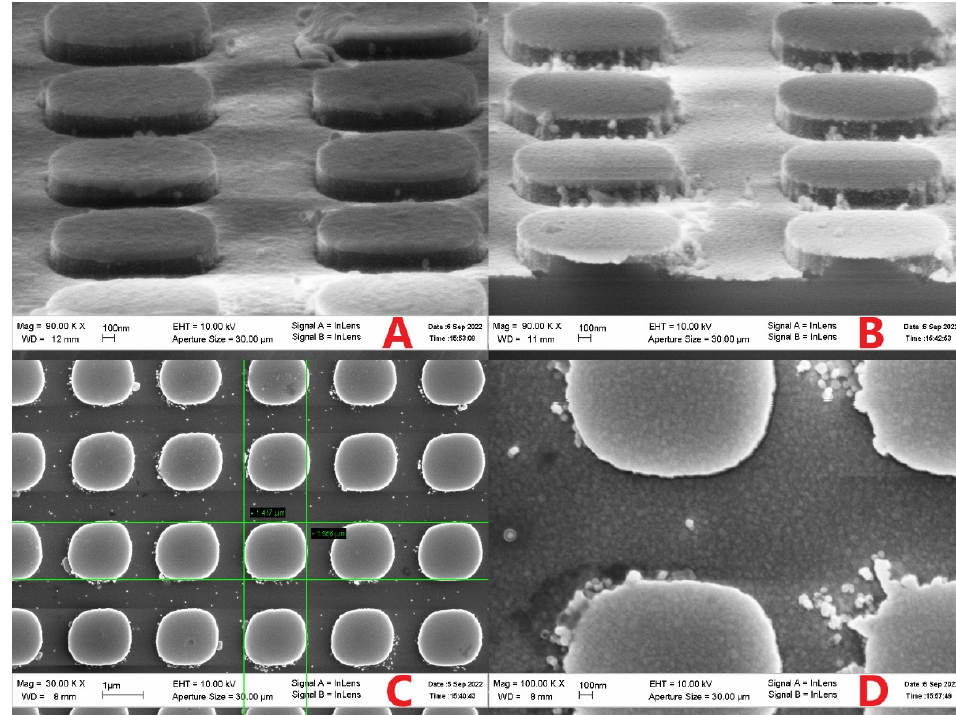
Figure 6. SEM images of the lithographic SERS structures with the aptamer SH-RBD-1C-Cy3. ( A ) The structure with the control influenza A virus. ( B – D ) The structures with SARS-CoV-2.